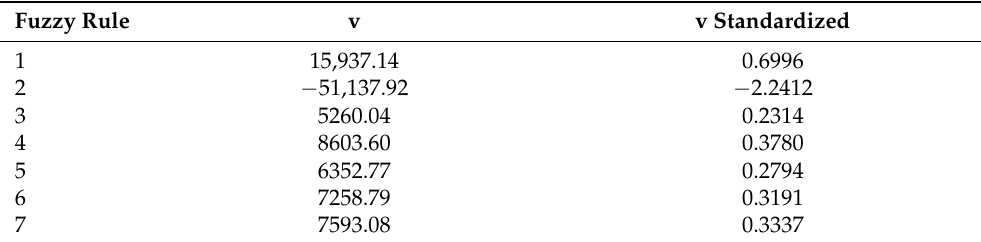
Table 3. Values of the consequents of the generated fuzzy rules.